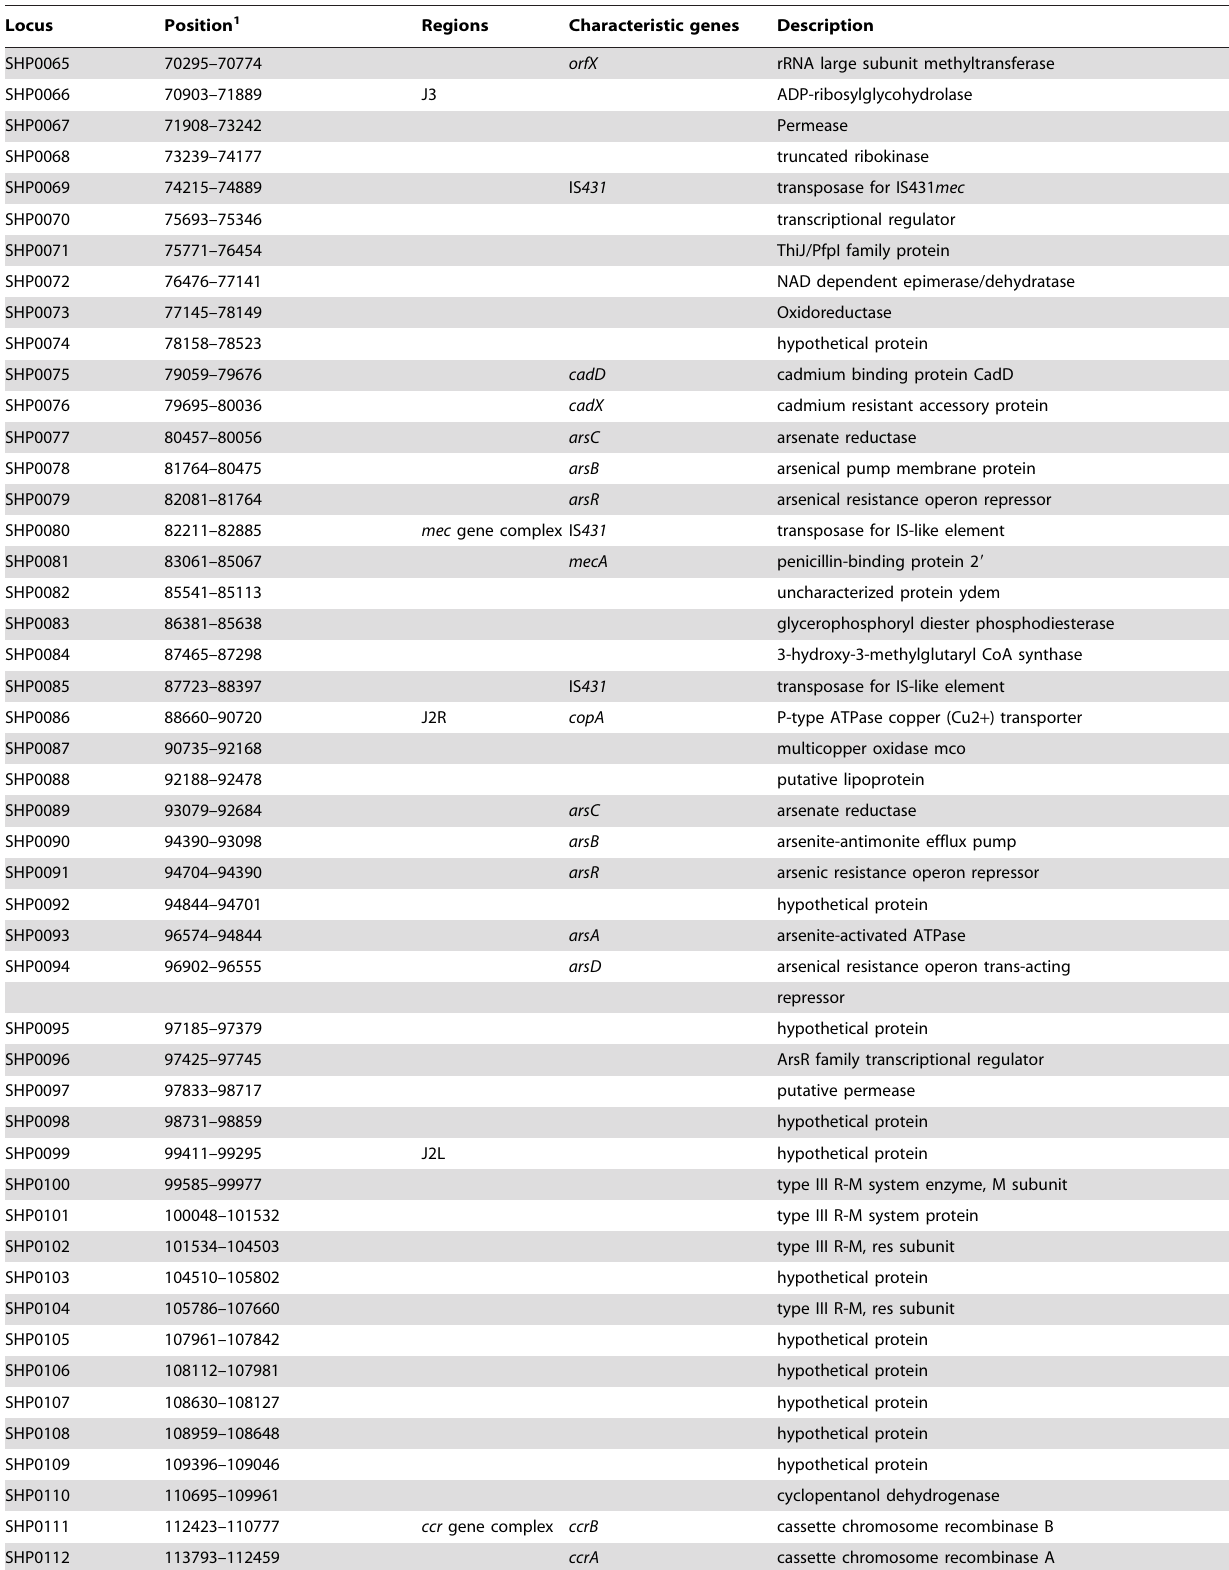
Table 1. Gene content of the SCC mec element in Staphylococcus haemolyticus SH32.